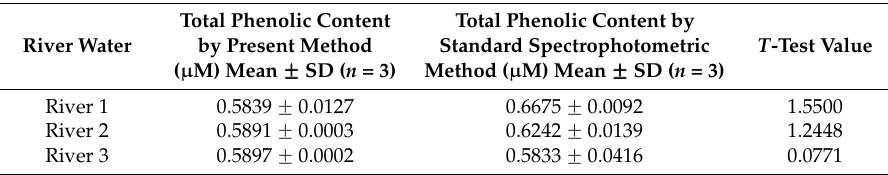
Table 4. Determination of spiked phenol in the matrix of river water ( n =